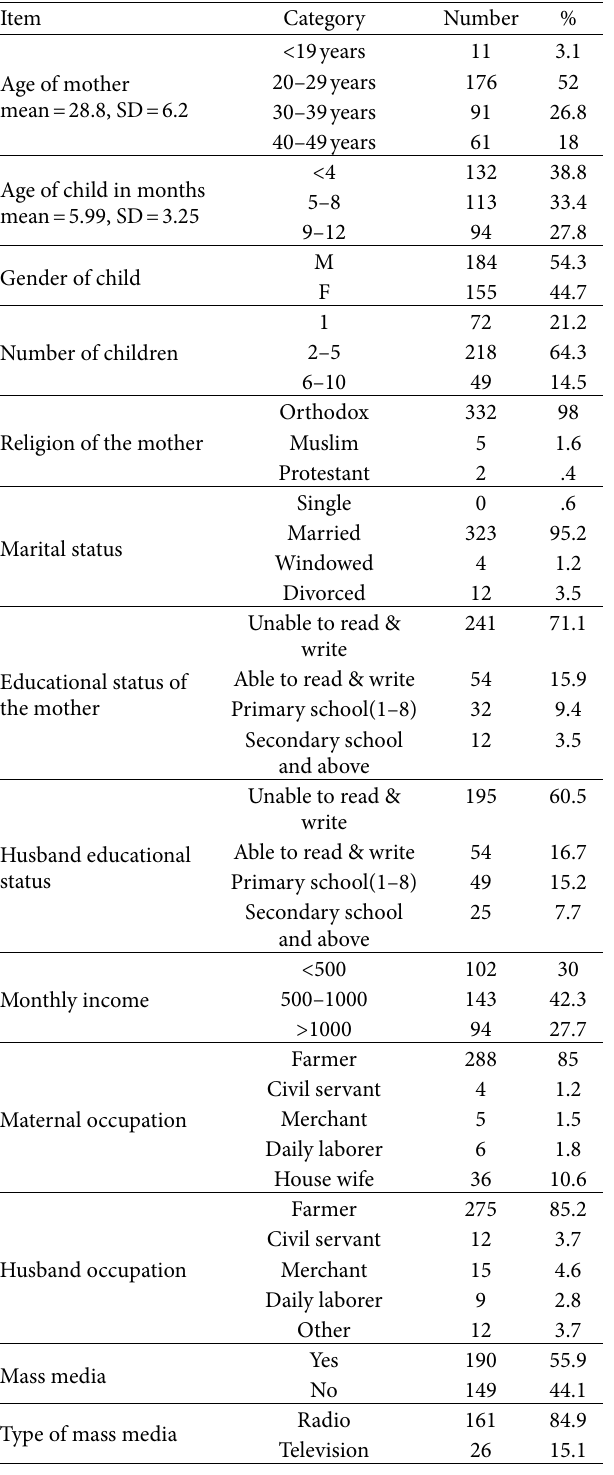
Table 1: Socio demographic characteristics of respondents whose child age was less than 12 months in Farta district, Northwest Ethi- opia, 2018.